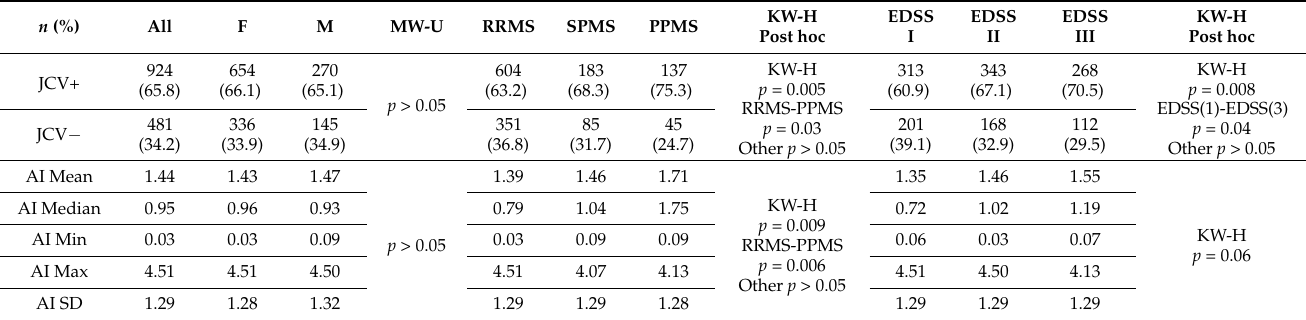
Table 2. Anti-JCV Ab prevalence and antibody index by patients’ sex, disease course and EDSS score. n (%)